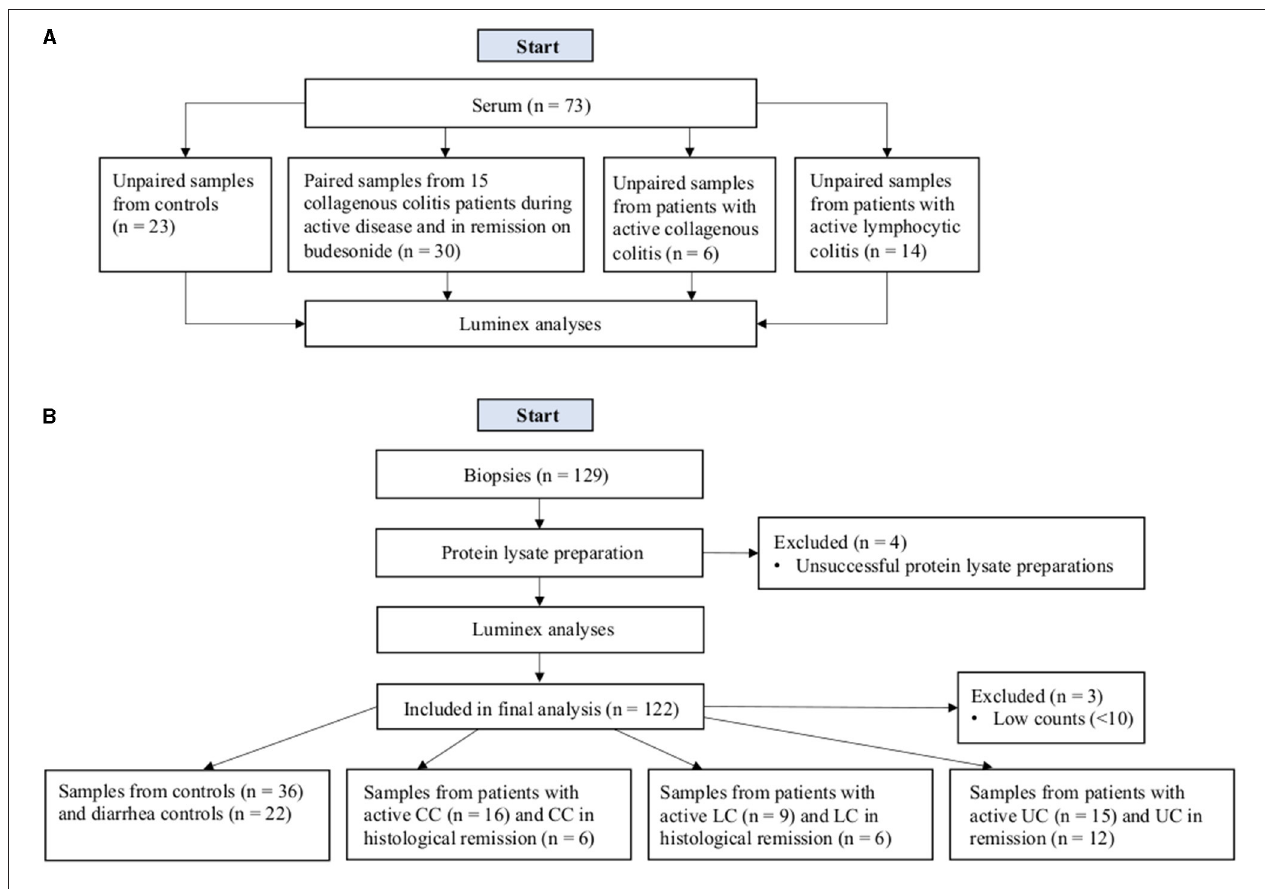
FIGURE 1 | Flowchart of the study design for serum samples (A) and biopsies (B)